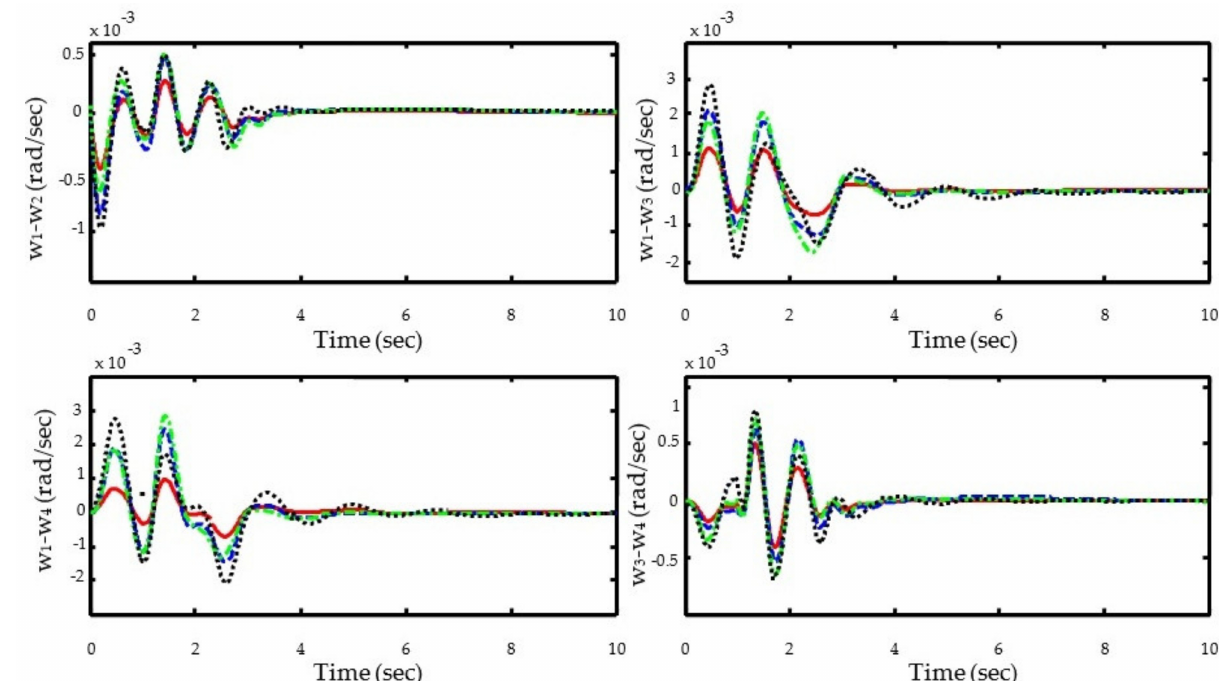
Figure 6. Angular velocity deviation for the first scenario for the rated load. Proposed (red line), BFA (blue dashed line), GA (green dash–dotted line), classic (black dots).